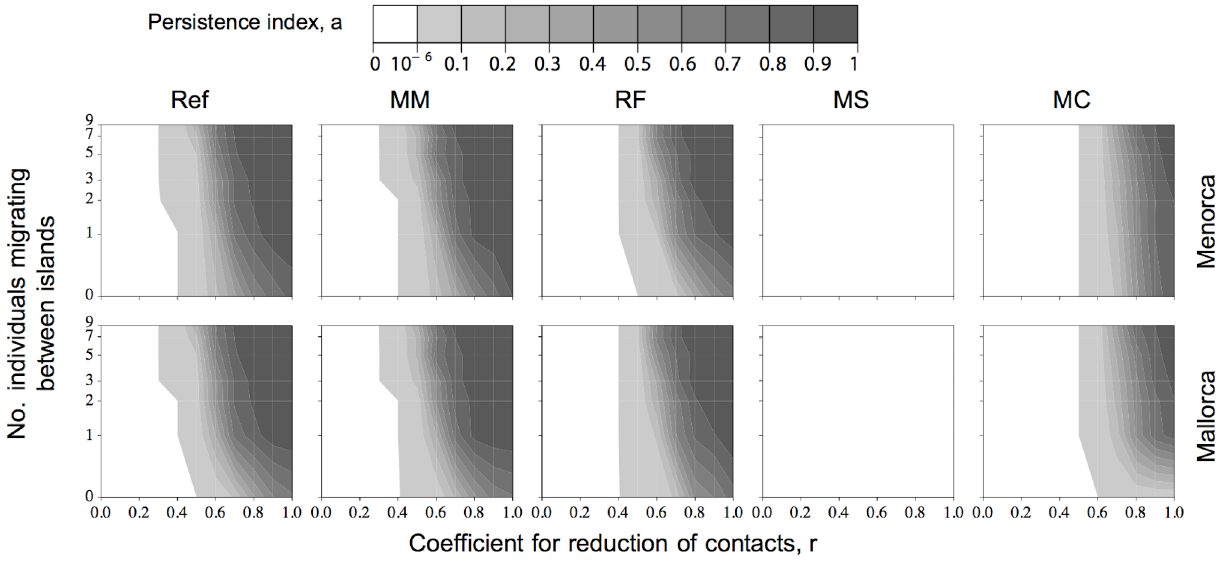
Figure 7. Individual bat species effect in EBLV-1 persistence. The persistence index is represented as in Figure 6. The first column corresponds to the reference scenario (Ref), in which none of the species is removed from the transmission process. The remaining columns correspond to the tested scenarios in which one after the other the indicated species is excluded from the transmission process. Abbreviations are as given in the legend to Figure 3.